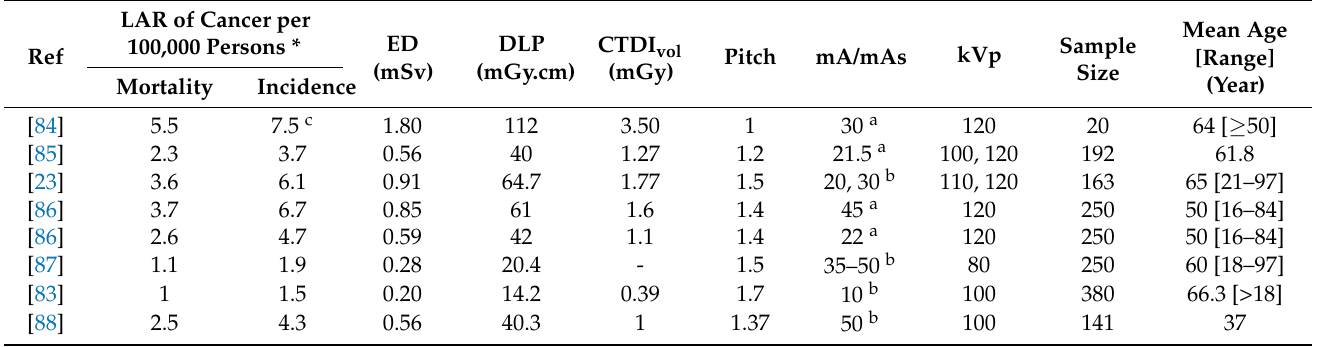
Table 4. The main scan settings, radiation doses and sex-averaged lifetime attributable risk of cancer incidence and mortality from low-dose chest CT for COVID-19 in the